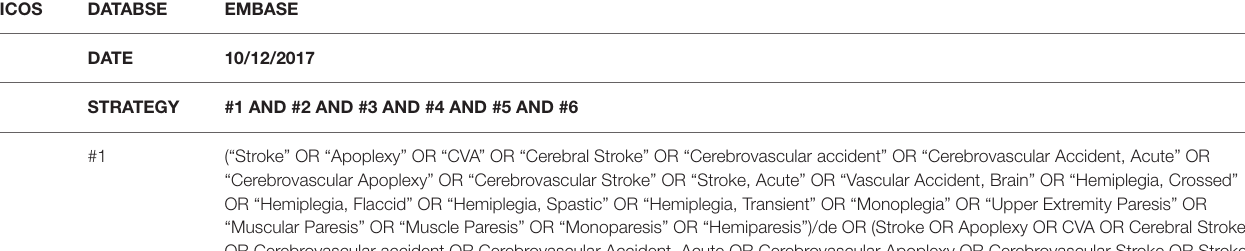
TABLE 1 | Sample search strategy EMBASE.